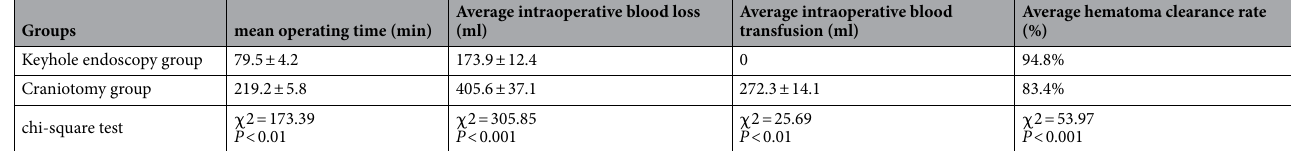
Table 1. Intraoperative comparison of the two patient groups.